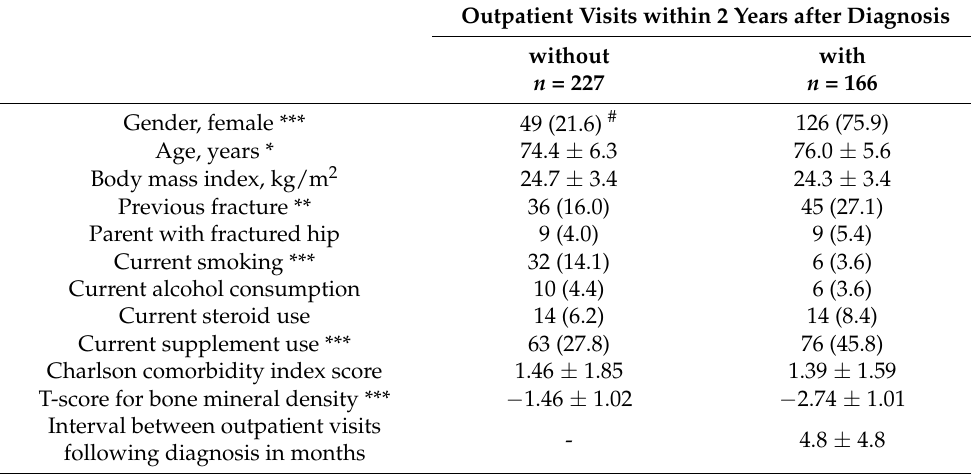
Table 1. Demographic characteristics of 393 subjects with osteoporotic vertebral fractures.